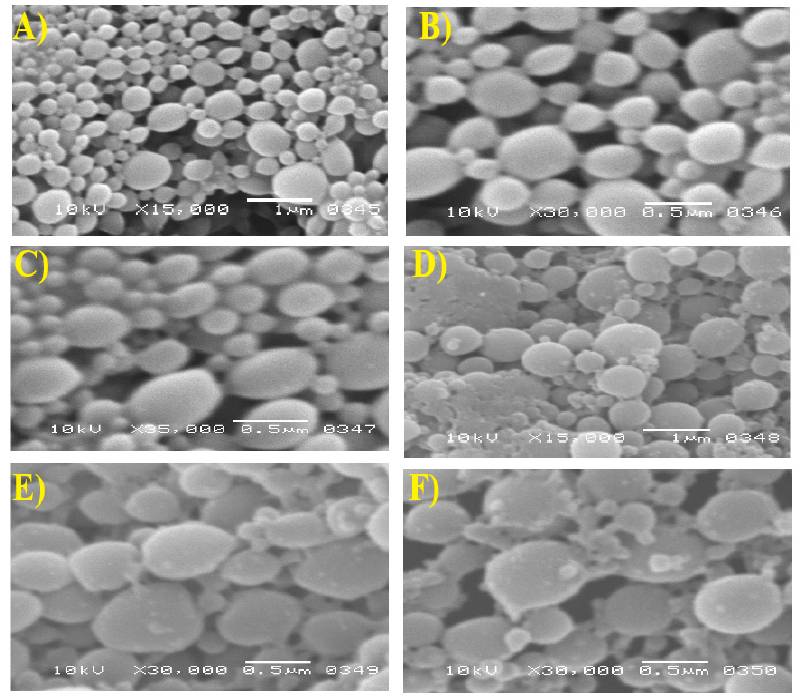
Figure 5. Scanning electron microscope images of ( A ) F1; ( B ) F2; ( C ) F3; ( D ) F4; ( E ) F7 and ( F ) F8.